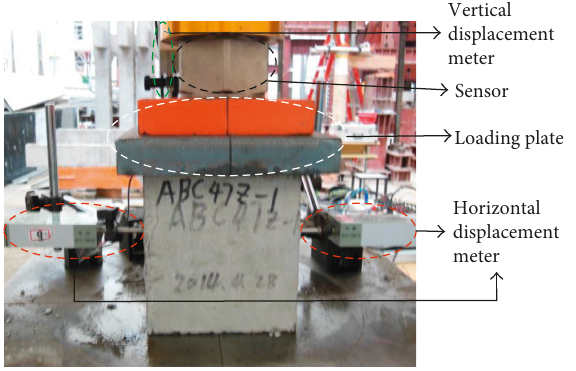
Figure 3: Test setup.